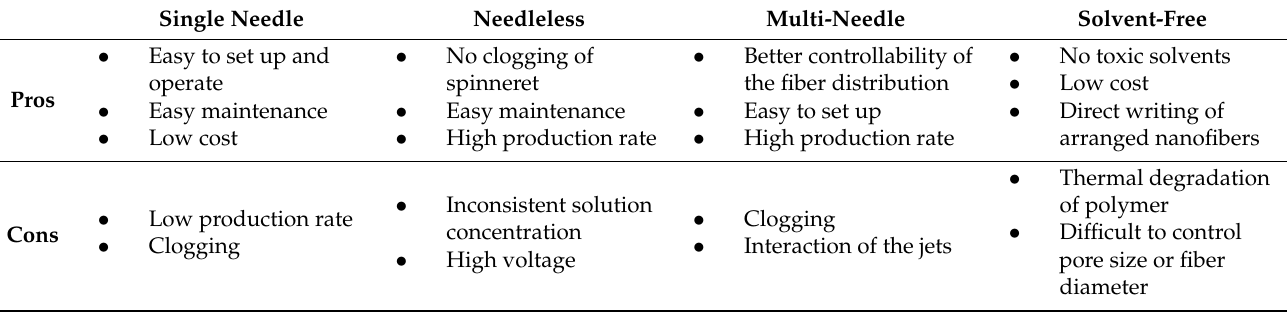
Figure 5. ( a ) Schematic diagram of melt differential electrospinning device. Reprinted with permission from ref. [42]. Copyright 2018 Wiley Periodicals, Inc. ( b ) Schematic illustration of a line-like CO2 laser M-ESP device. Reprinted with permission from ref. [43]. Copyright 2019 Society of Plastics Engineers. ( c ) Composite PEBA fiber synthesis mechanism for Melt-electrospinning process. Reprinted with permission from ref. [46]. Copyright 2019 Elsevier Ltd. Table 2. Brief comparison of four electrospinning